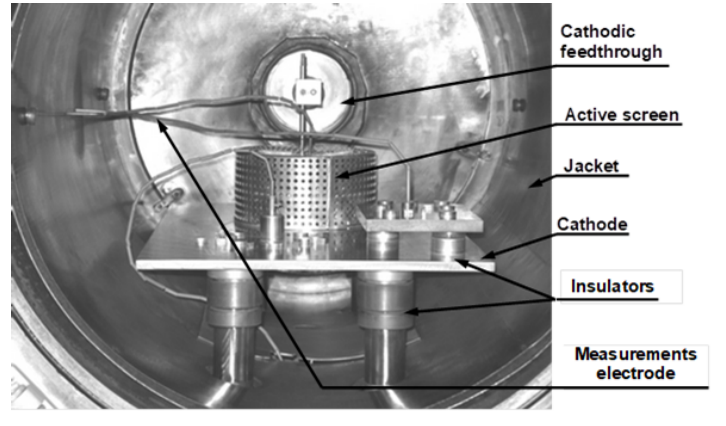
Figure 6. The interior of the plasma furnace. Test samples (see Figure 7) were made in the form of rectangular prisms of a base of 20 × 15 mm and a height of 15 mm.